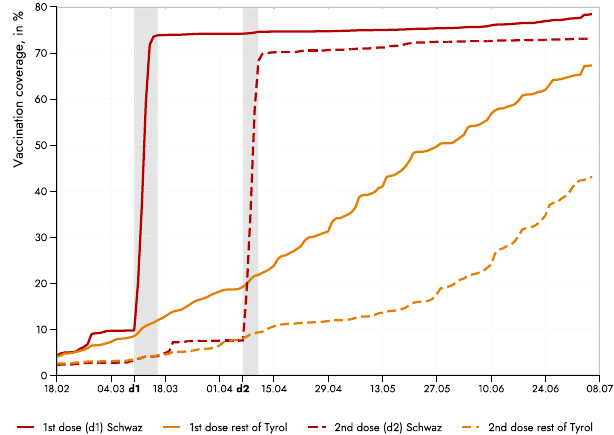
Fig. 1 Vaccination coverage of adult population in Schwaz and the rest of Tyrol. The fi gure displays the shares of the adult population that received the fi rst (solid line) and second dose (dashed line) of vaccination, respectively. Schwaz is plotted in red, while the other (eight) Tyrolian districts are pooled and their mean depicted in orange. The shaded areas indicate the period of the fi rst (d1: 11th to 16th of March 2021) and the second (d2: 8 – 11 April 2021) roll-out of mass